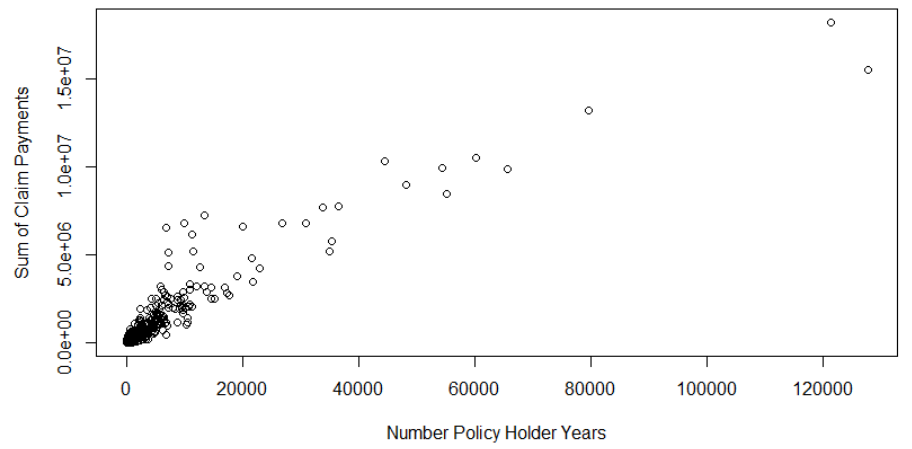
Figure 9. Scatterplot of the Swedish motor